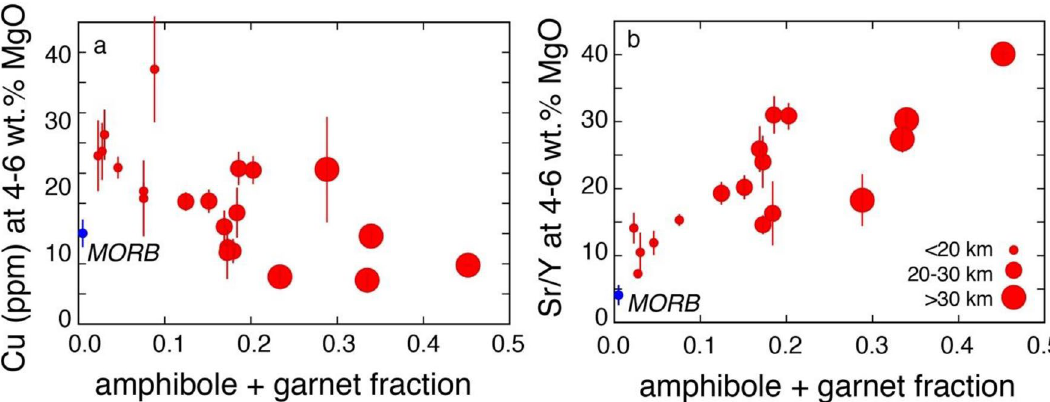
Figure 9. Proportions of fractionating minerals versus Cu and Sr/Y. ( a ) Proportions of fractionating amphibole versus Cu at 4–6 wt% MgO (as defined by 7 ); ( a ) proportions of fractionating plagioclase versus Sr/Y at 4–6 wt% MgO (as defined by 8 ). Different circle sizes highlight different arc crust thicknesses. Bismark-New Britain and New Hebrides are excluded from the plot b because their high Sr/Y values likely result from slab melting 8